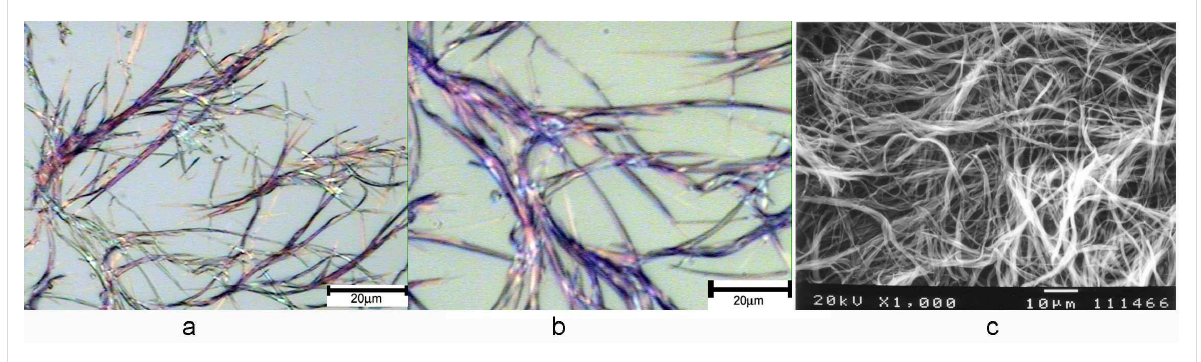
Figure 5: Optical micrographs under bright field (a, b) and scanning electron micrograph (c) of the gel formed by compound 18A in ethanol after exposure to UV light for 3 min. Blue-purple fibers were observed in (a) and (b), and an entangled fibrous network was observed in (c).